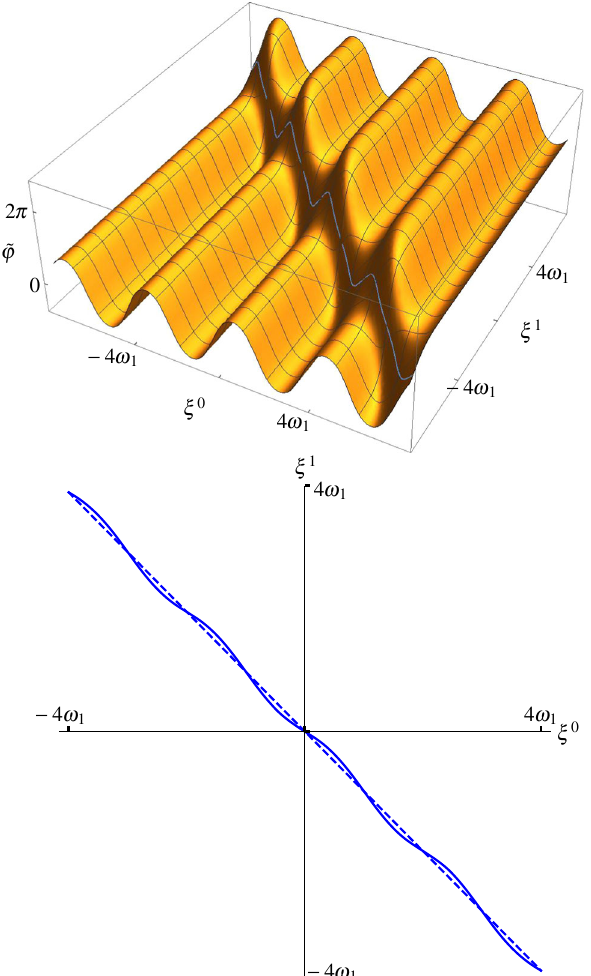
Fig. 4 The solution for an oscillating background with E = 7 μ 2 / 10 and Bäcklund parameter a = 2. The blue line indicates the position of the kink. The dashed line is the average position. Its inclination is the mean velocity of the